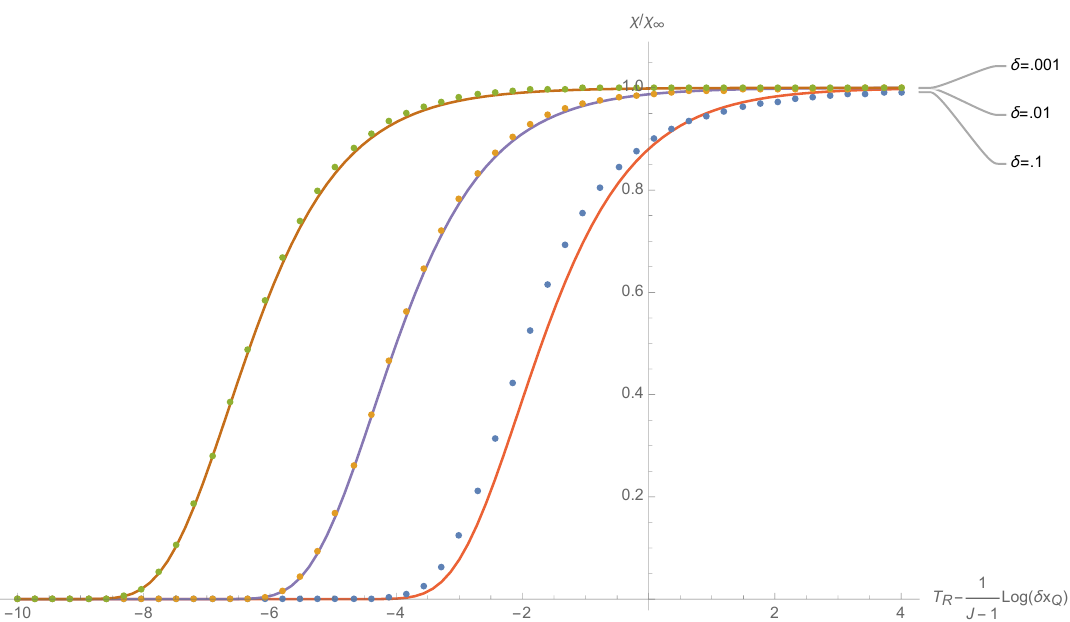
Figure 6 . We plot the fidelity susceptibility normalized by its value at T R = ∞ for J = 3 / 2 , ∆ = 1 / 2 and ∆ = 1 / 8 . We have shifted the time axis so that the origin corresponds to φ O where δx ( J ) is defined in (4.14) as the crossover time for the full modular energy. e ( J − 1) T R = δx ( J ) Q Q The dots are numerically generated values and the lines are given by equation (6.24) for the various δ ’s. We see fairly good agreement with the answer found via saddle point